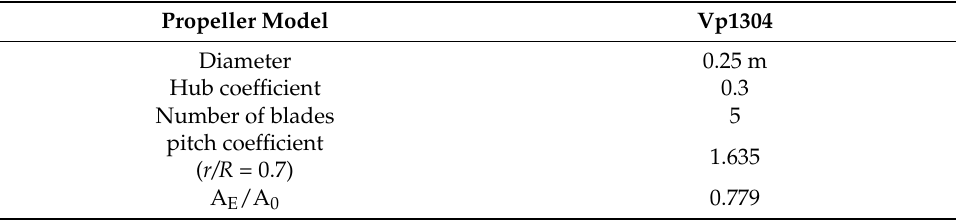
Table 1. Geometrical specification of the propeller.